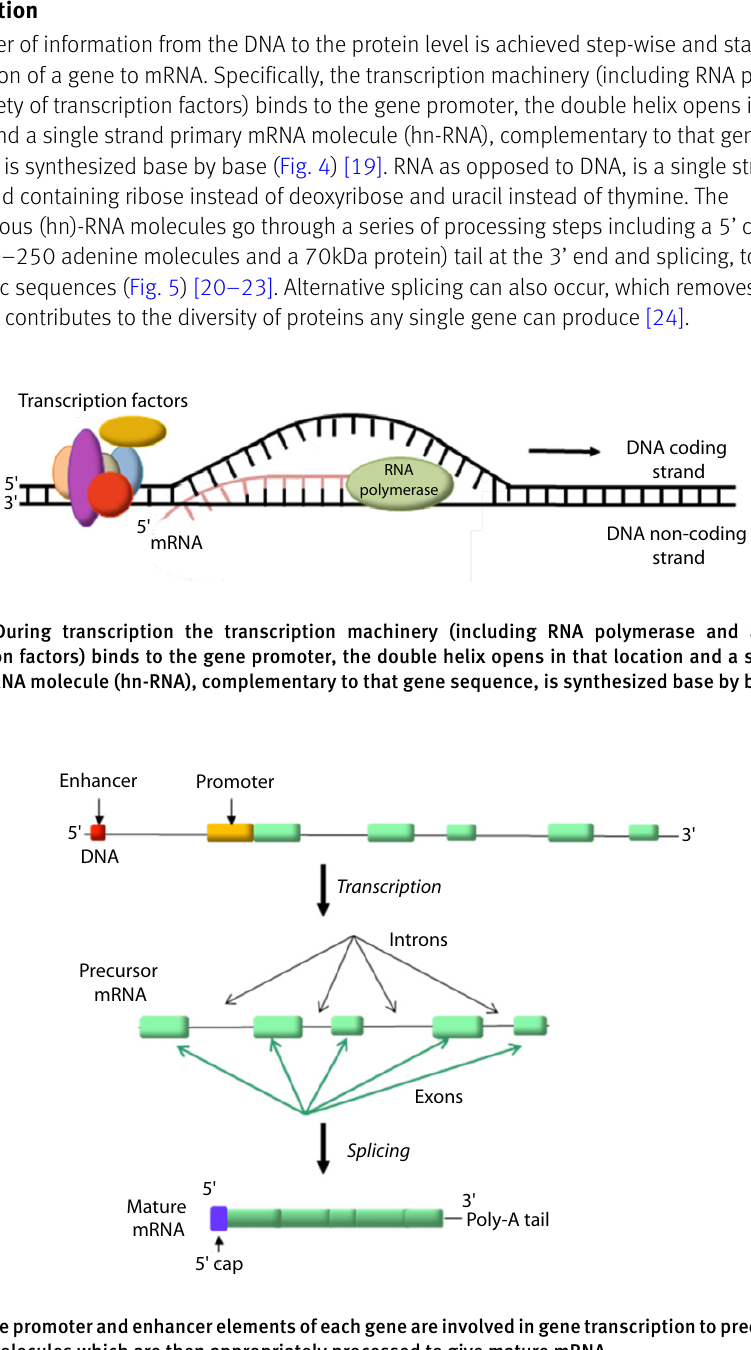
Figure5. ThepromoterandenhancerelementsofeachgeneareinvolvedingenetranscriptiontoprecursormRNA (hn-RNA) molecules which are then appropriately processed to give mature